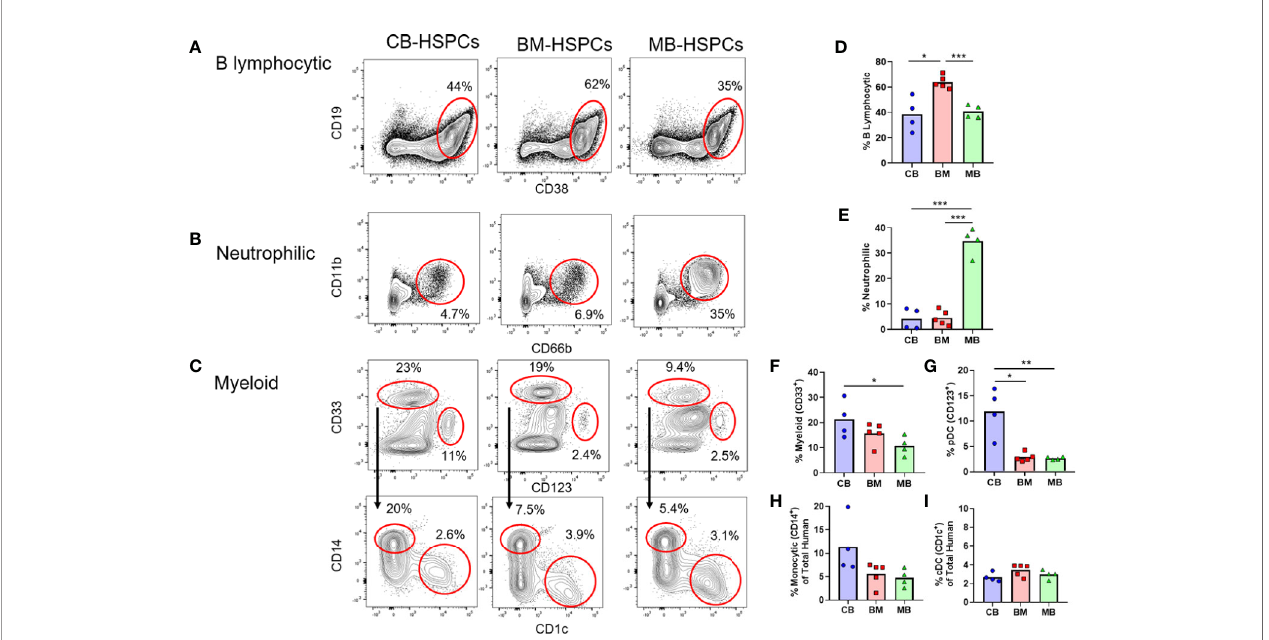
FIGURE 4 | Source of human HSPCs in fl uences hematopoietic output. The lineage output resulting from transplantation of CB-, BM-, or MB-HSPCs was examined by fl ow cytometry of murine bone marrow after 12 weeks. (A – C) Representative plots showing fl ow cytometric analysis of human cells (panHLA-I + , murine CD45 − ) in the bone marrow of NBSGW mice given 5E 5 HSPCs. (A) Identi fi cation of B lymphocytic cells (CD19 + , CD38 high ). (B) Identi fi cation of neutrophilic cells (CD11b + , CD66b + ). (C) Identi fi cation of myeloid lineage cells (CD33 + gate in top row), that are comprised of monocytic cells (CD14 + gate in bottom row) and DCs (CD1c + gate in bottom row). Additionally, a progenitor population that is thought to give rise to plasmacytoid DCs and other cells is present (CD33 − CD123 + gate in top row). (D – I) Plots showing the percent of each population within the human compartment of mice given the indicated sources of HSPCs. Symbols show results from individual mice, bars represent the arithmetic means. *p < 0.05; **p < 0.01; ***p <